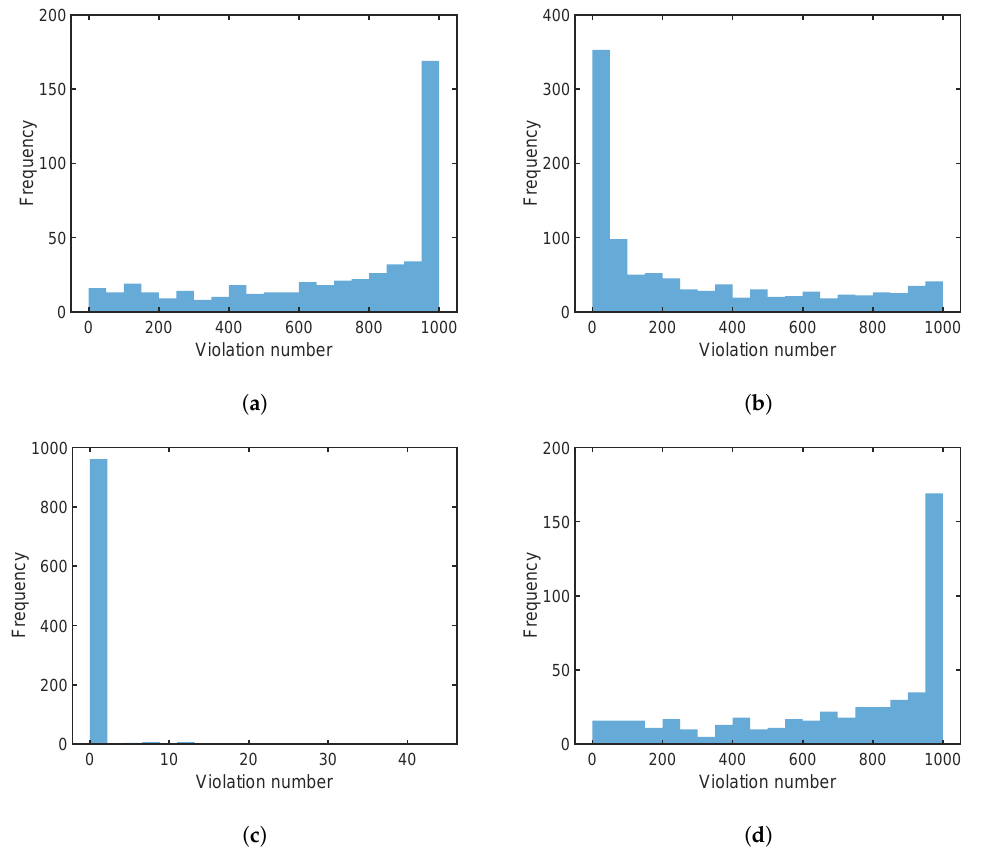
Figure 6. Normalized histograms of constraint violations for the ( a ) nominal, ( b ) robust, ( c ) p-box robust (plausibility function), and ( d ) p-box robust (belief function) process designs. The probability that the violation number ≥ 10 is the highest for the nominal design; see Figure